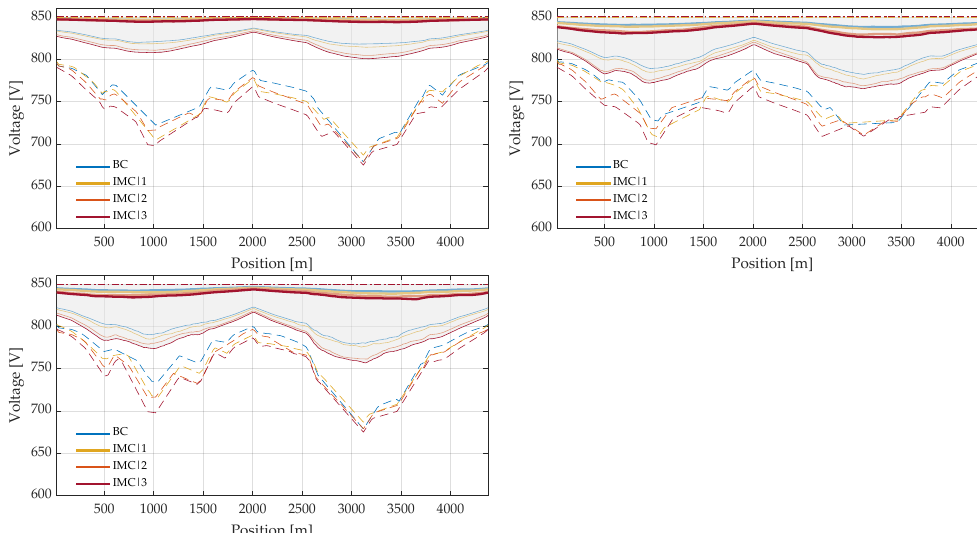
Figure 23. Voltage along the catenary for the four considered scenarios. Voltage maximum (dot- dashed lines) and minimum (dashed lines), mean (upper solid lines), and 95% central inter-percentile range (filled areas above bottom solid lines). Results for the simulations of: 24 h ( left ), 07:00 to 10:00 ( right ), and 17:00 to 20:00 (bottom).